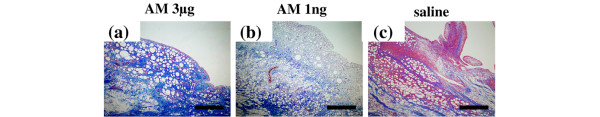
Histological analysis of infrapatellar fat-pad sections stained with Mallory – Azan from rabbits with antigen-induced arthritis. Rabbits with antigen-induced arthritis (AIA) were treated with daily injections of adrenomedullin (AM) or saline (control) into the knee joint spaces for 20 days. The infrapatellar fat pads were harvested from rabbit knees 21 days after arthritis induction. The tissues were sectioned longitudinally perpendicular to the patella ligament in the middle of the tissue, and were stained with Mallory – Azan. (a) AIA rabbit knee was treated with daily intra-articular injections of 3 μg AM for 20 days. (b) AIA rabbit knee was treated with daily intra-articular injections of 1 ng AM for 20 days. (c) The contralateral knee of (a) was treated with daily intra-articular injections of saline for 20 days. Photographs taken at ×40 magnification. Bar = 500 μm.